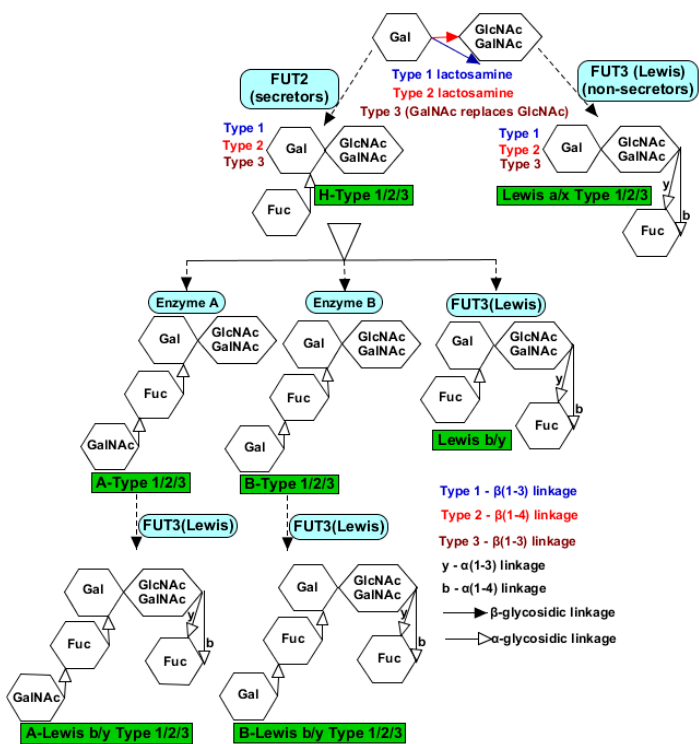
Figure 2. Terminal oligosaccharides of histo-blood group antigens (HBGAs) receptors that facilitate rotavirus VP8* binding. Terminal fucose is catalysed by α -1,2-fucosyltransferase 2 encoded by the FUT2 gene, generally referred to as “secretor” to form an H-type glycol-receptor, which can remain unmodified as type O + secretor. However, when terminal fucose is catalysed by α -1,4-fucosyltransferase 3 encoded by the FUT3 gene and remained unmodified, it becomes type O - non-secretor. Subsequent modification produced A-type, B-type, Lewis, A-Lewis, and B-Lewis. Terminal -GalNAc in the A-type makes it vulnerable to many rotavirus strains and enhances inter-species transmission.